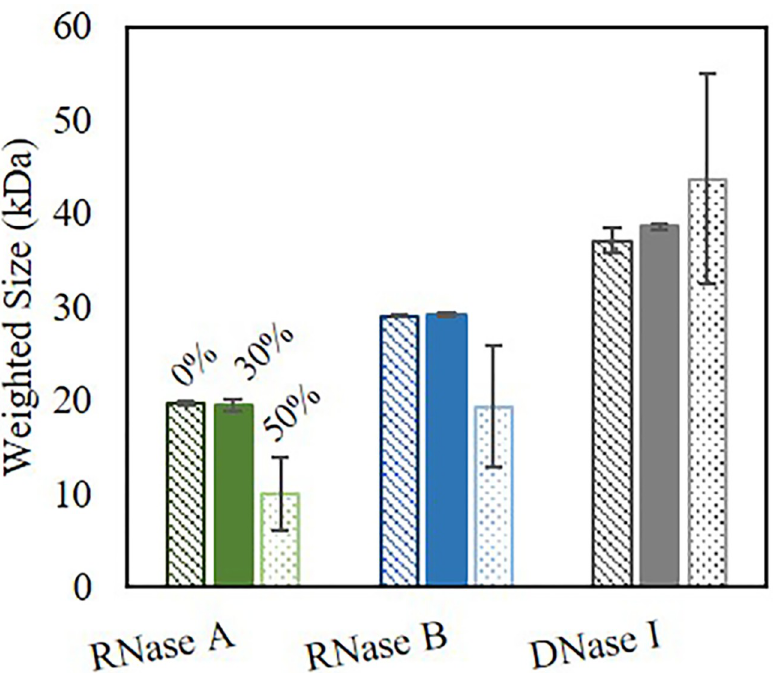
Fig 5. Weighted size (kDa) of RNase A, RNase B, and DNase I. Weighted size post microwave irradiation of 30% and 50% power, 60 seconds as compared to pre (0%) . In general, as microwave power increases, the overall weighted nuclease size decreases and the error in the size becomes larger. This in indicative of an increasing number of varying size fragments with an overall degraded nuclease.